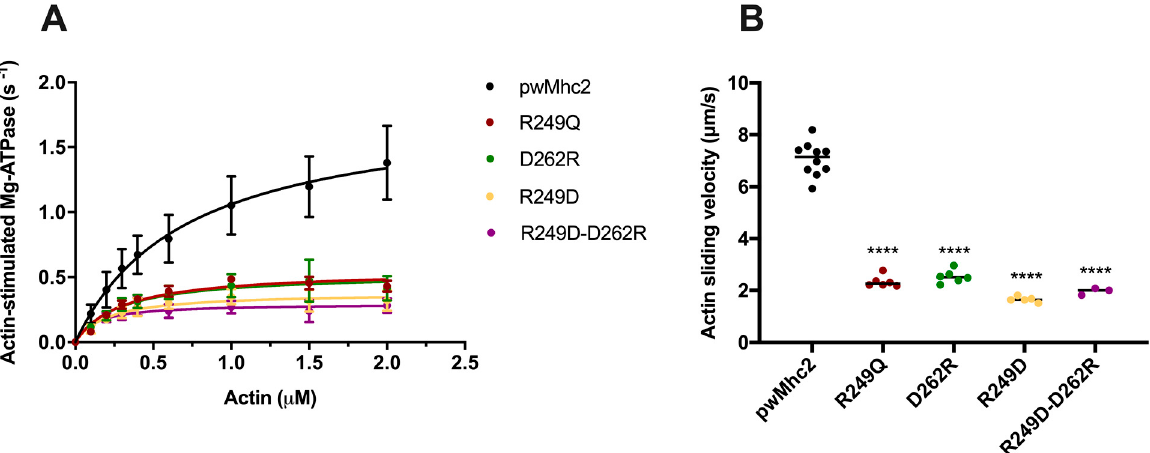
Figure 5. Actin-stimulated ATPase and actin sliding velocity values are reduced for R249Q, R249D, D262R and R249D-D262R myosin molecules. ( A ) Actin-stimulated Mg-ATPase levels are plotted relative to actin concentration for control (PwMhc2) and mutant myosins, after subtraction of basal Mg-ATPase values determined in the absence of actin. Each of the mutant myosins dramatically reduces Mg-ATPase activity relative to control (see Table 3 V max values) and decreases the concentration of actin needed to yield half-maximal ATPase activity (see Table 3 K m values). No statistically significant improvement is observed in myosin containing the R249D-D262R double mutation relative to the single mutations. ( B ) Actin sliding velocities calculated for control (PwMhc2) and mutant myosins. All mutations significantly decrease actin sliding velocities (****) and no improvement is observed in myosin containing the R249D-D262R double mutation relative to the single mutations (Table 3).